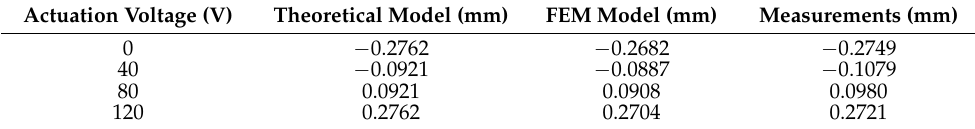
Table 3. Comparison of free strokes between model outputs and experimental